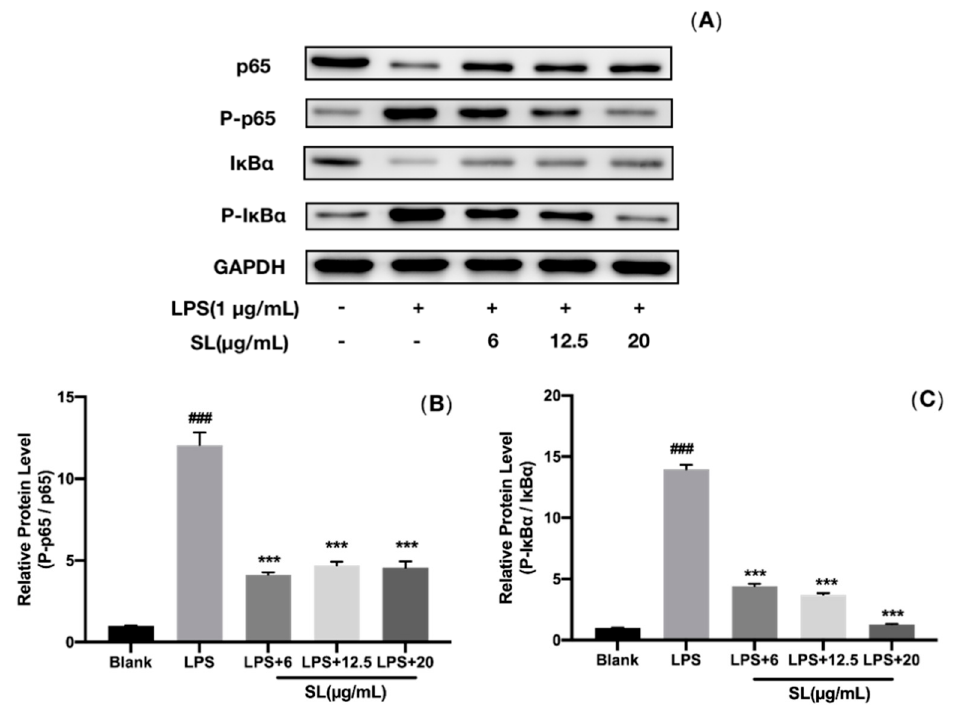
Figure 7. SLs inhibited the phosphorylation of NF- κ B pathway-related protein in LPS-induced RAW264.7 cells. Cells were incubated with LPS (1 μ g/mL) with or without SL for 18 h. ( A ) Western blot protein bands; ( B , C ) relative protein levels. The results are presented as the mean ± standard error (n = 3), and a p -value less than 0.05 was expressed as statistically significant (###, p < 0.001 vs. blank group; ***, p < 0.001 vs. LPS treatment group).